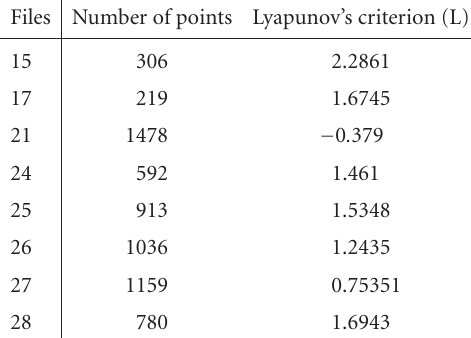
Table 4.2. Estimation of pressure pulses chaos degree by largest Lyapunov’s